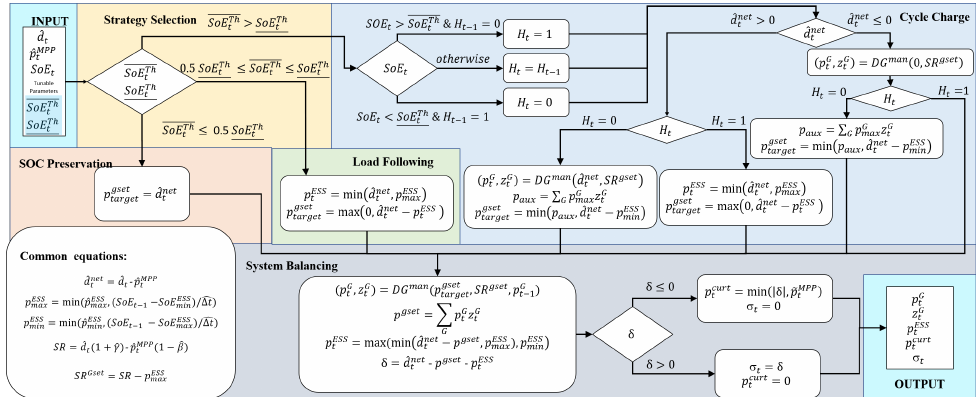
Figure 4. Schematic representation of the Tunable Rule-Based Heuristic (TRBH) decisional